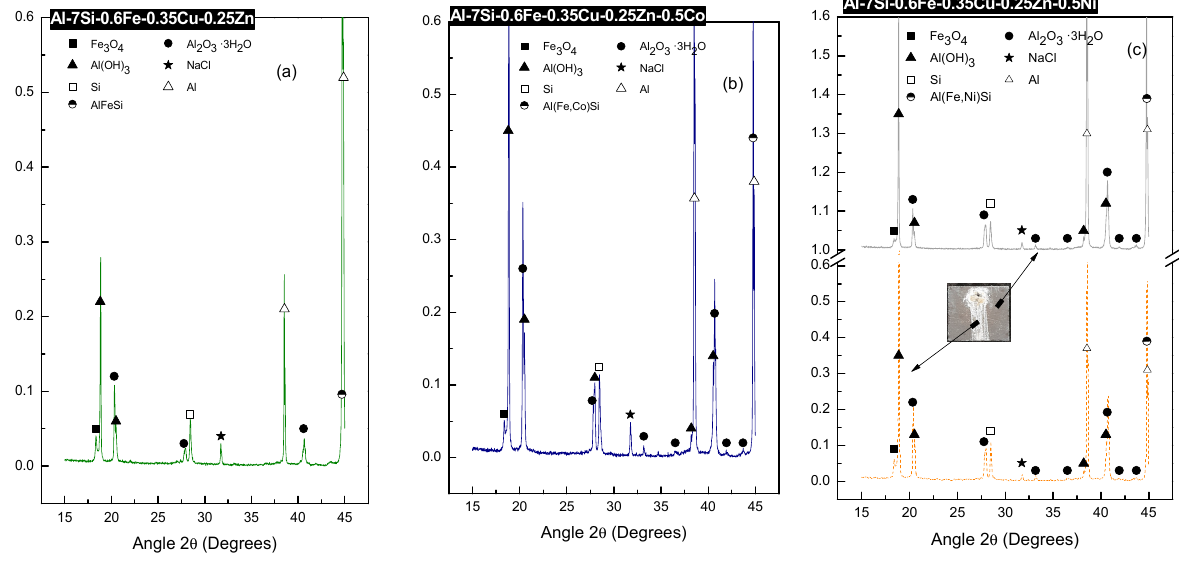
Figure 11. XRD patterns of the alloys solidified at higher cooling rates (CC samples): ( a ) Al-7%Si- 0.6%Fe-0.35%Cu-0.25%Zn, ( b ) Al-7%Si-0.6%Fe-0.35%Cu-0.25%Zn-0.5%Co and ( c ) Al-7%Si-0.6%Fe- 0.35%Cu-0.25%Zn-0.5%Ni.